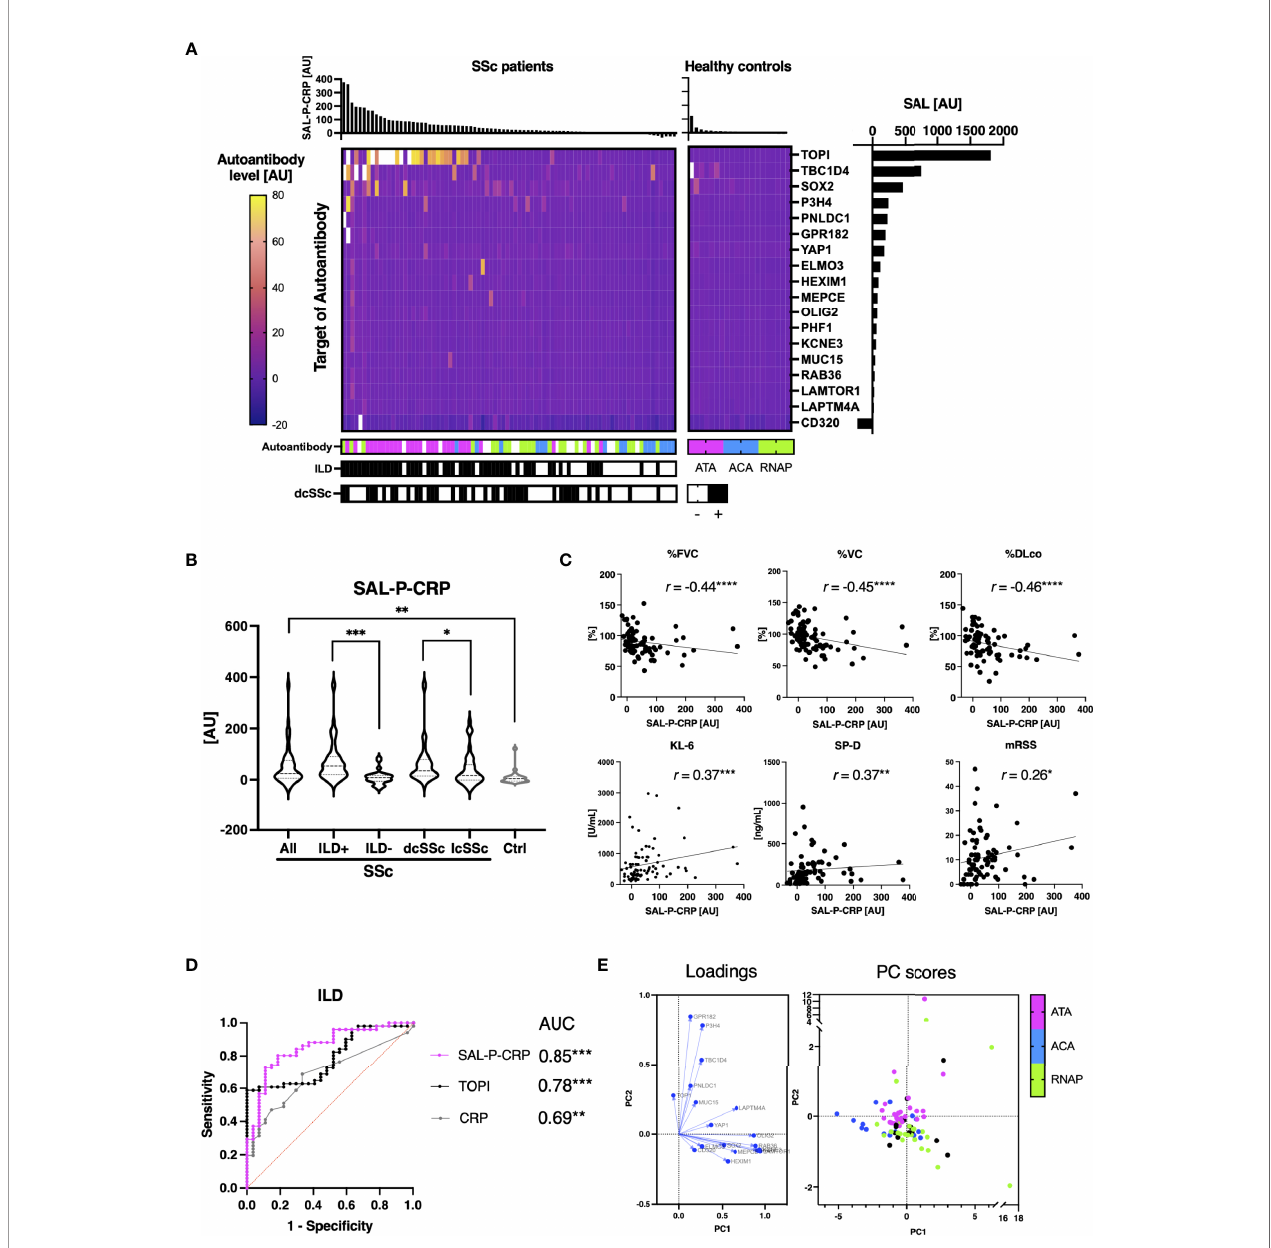
FIGURE 3 | Association between sum of autoantibody levels and clinical presentation in patients with systemic sclerosis. (A) Heatmap of 18 autoantibodies that positively correlate with serum levels of C-reactive protein (CRP) with statistical signi fi cance in individual sera of systemic sclerosis (SSc). The targets of autoantibodies are described with the gene symbols of their origin. Each case was labeled with the highest serum level among anti-topoisomerase I (ATA), anti-centromere (ACA), and anti- RNA polymerase III (RNAP) antibodies. SAL-P-CRP: sum of autoantibody levels that positively correlated with serum CRP with statistical signi fi cance. AU: arbitrary unit. (B) Violin plots of SAL-P-CRP in individual sera of SSc patients and healthy controls. Subpopulation analysis revealed that SAL-P-CRP was signi fi cantly elevated among SSc patients with interstitial lung disease (ILD) or diffuse cutaneous SSc (dcSSc) compared to limited cutaneous SSc (lcSSc). P values were calculated by Mann-Whitney U test. (C) Correlation between SAL-P-CRP and pulmonary function, serum ILD markers, skin thickness score, and serum CRP levels. r: Spearman ’ s correlation coef fi cient. P values were calculated by estimating r . %FVC: percentage of predicted forced lung vital capacity, %DLco: percentage of predicted lung diffusing capacity for carbon monoxide, KL-6: Krebs von den Lungen-6, SP-D: surfactant protein-D, mRSS: modi fi ed Rodnan ’ s total skin thickness score. (D) Receiver-operator characteristics curve of accuracy detecting ILD. Area under the curve (AUC) was the biggest for SAL-P-CRP, compared to those for ATA levels (TOP1) or for CRP levels. (E) Principal component (PC) analysis. Two-dimensional scattering isolated three representative subpopulations of SSc: ATA, ACA, and RNAP-positive groups. Each case was labeled with the highest serum level among ATA, ACA, and RNAP. PC1, the primary principal component. PC2, the secondary principal component. * P < 0.05, ** P < 0.01, *** P < 0.001, **** P <